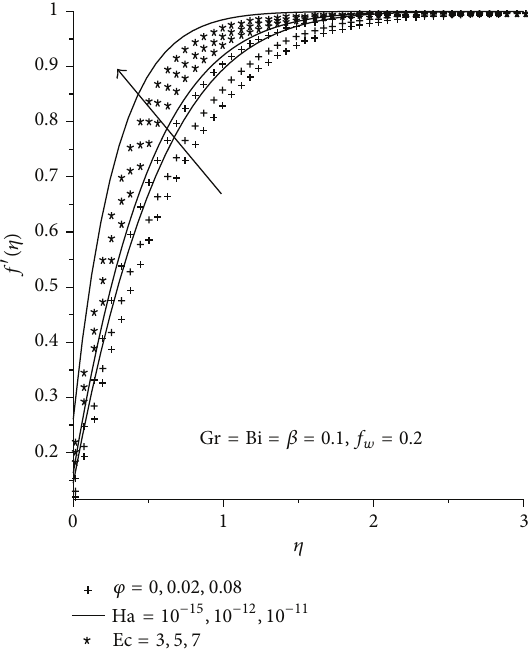
Figure 3: Velocity profiles with increasing Ha, 𝜑 , and